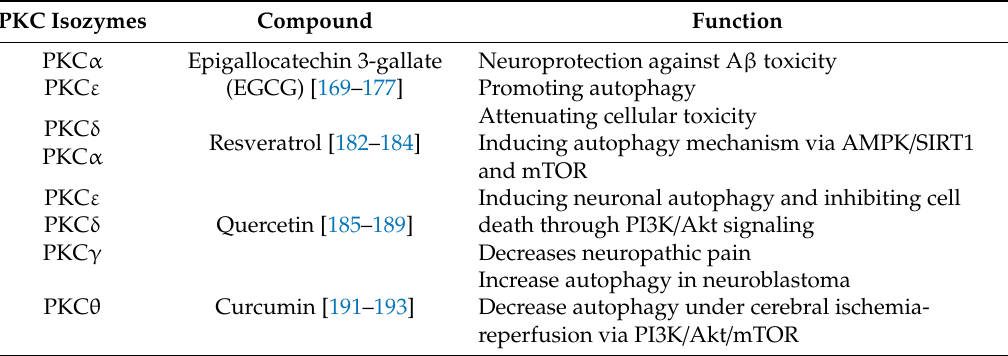
Table 1. Natural compounds’ e ff ects on protein kinase C isozymes and